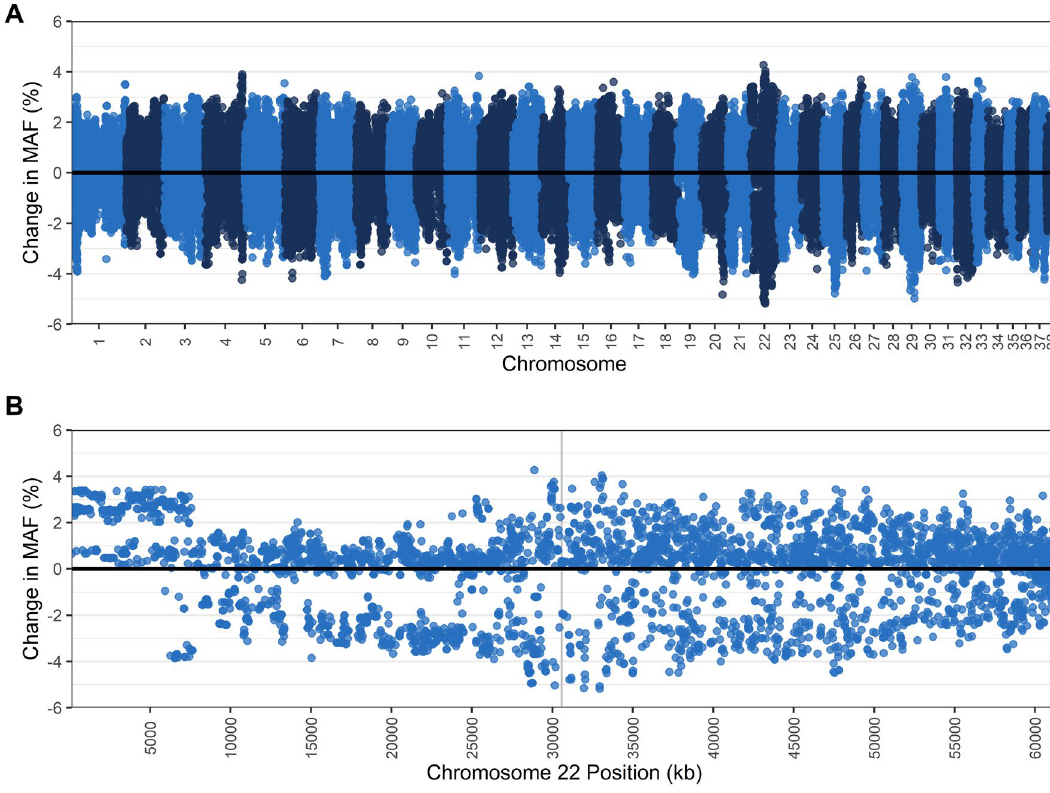
Figure 4. Change in the minor allele frequency (MAF) ( A ) across all autosomes and ( B ) within chromosome 22, where the CLN5 gene is located (position shaded in grey), when NCL carriers (N = 29) are removed from the population, leaving dogs clear of the NCL mutation (N = 184). Each dot represents a single nucleotide polymorphism (0.008 to 0.099) 18,23–25 . The mean genealogical inbreeding estimates for GenoPed was higher (F ped = 0.139, SD 0.063) compared to molecular estimates for these animals (F geno = 0.042, SD = 0.076). These values are not directly comparable due to differences in calculation for the different data types, but pedigree estimates of inbreeding has